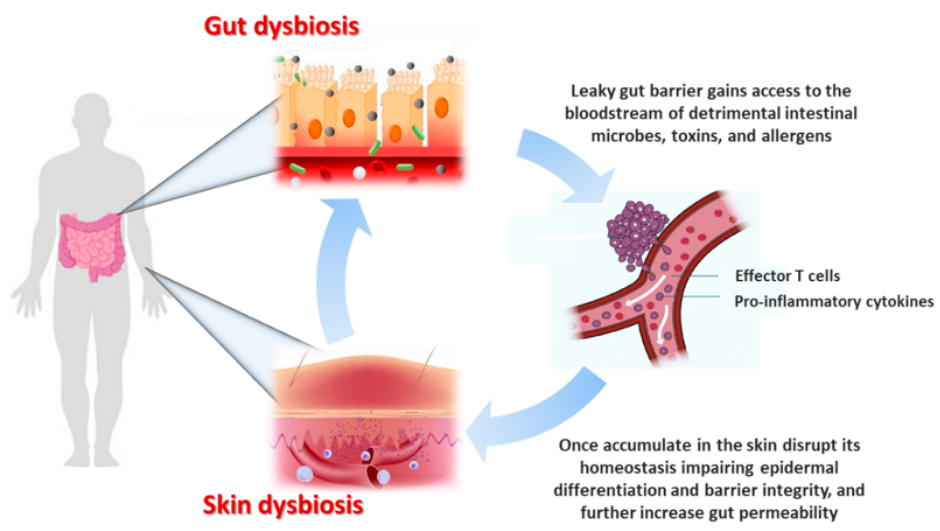
Figure 2. Given the bidirectional crosstalk between the gut and the skin, referred to as the “gut–skin axis”, it is unsurprising that gut disorders are often accompanied by cutaneous manifestations. GM dysbiosis increases epithelial permeability and the leaky gut barrier gains access to the bloodstream of detrimental intestinal microbes and toxins, which once accumulated in the skin can disrupt its homeostasis impairing epidermal differentiation and barrier integrity. GM dysbiosis trigger the activation of effector T cells, disrupting their balance with immunosuppressive counterpart regulatory T cells (Tregs). These effector cells and their pro-inflammatory cytokines are supposed to directly contribute to the pathogenesis of several skin inflammatory dermatoses. In turn, pro-inflammatory cytokines further increase gut permeability setting up a vicious cycle of systemic inflammation with deleterious consequences for the